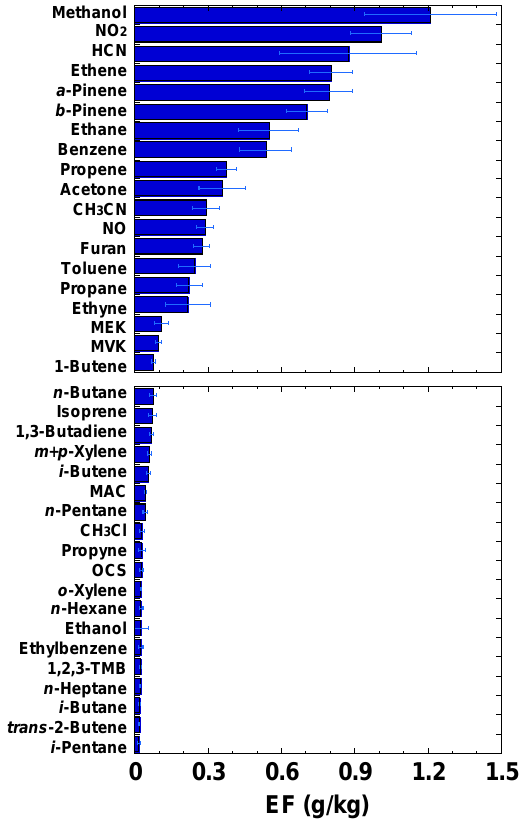
Figure 12. Emission factors for NO 2 , NO, HCN, CH 3 CN, and the top 34 NMVOCs emitted from fresh Canadian boreal forest fires, excluding CH 2 O. The results show the importance of light NMVOCs and the pinenes, and the co-emission of a wide range of compound classes from the fires.